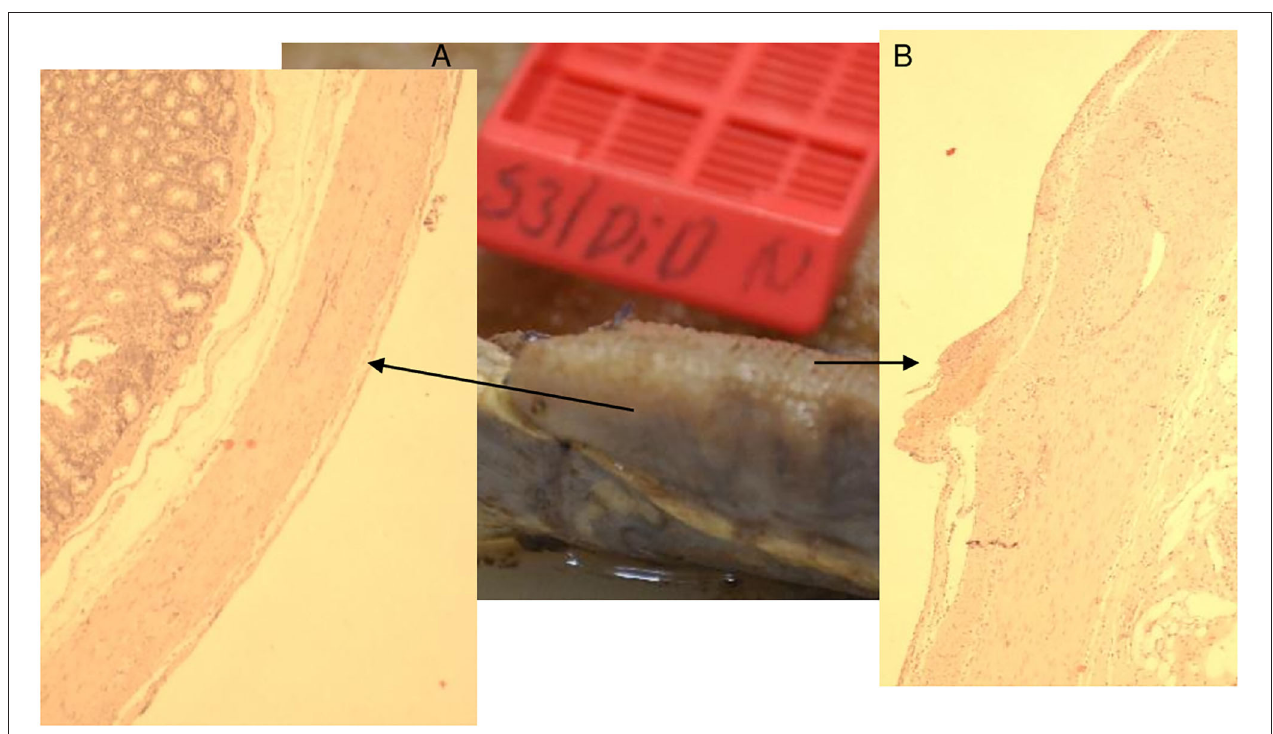
FIGURE 8 | Animal 3, − 80 mmHg Colon histology. (A) Without patch, smooth surface. (B) Spikes with serosa, subserosa, and hardly any lamina muscularis